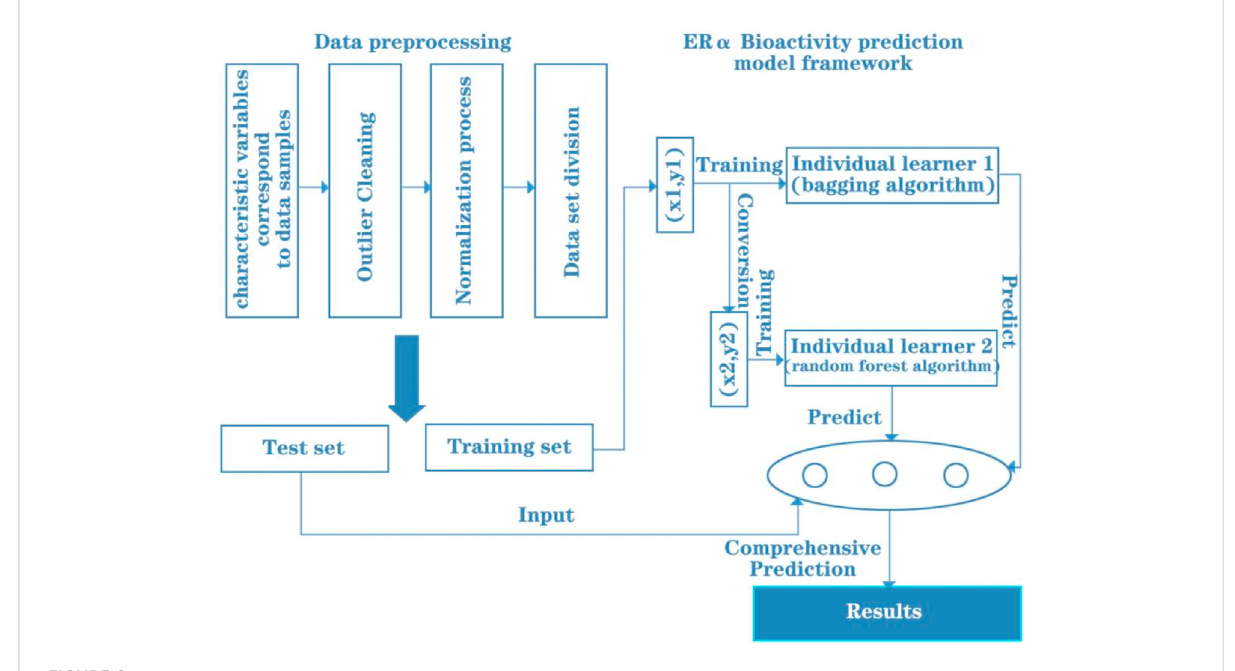
FIGURE 2 Framework of ER α bioactivity prediction model.